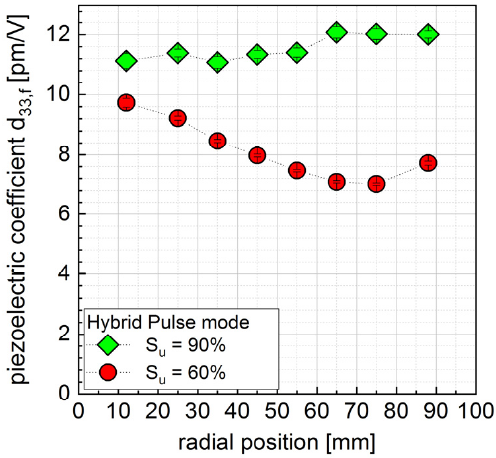
Figure 6. Dependency of d 33,f of 1 µ m AlScN films on radial position and share of unipolar pulse mode S u.